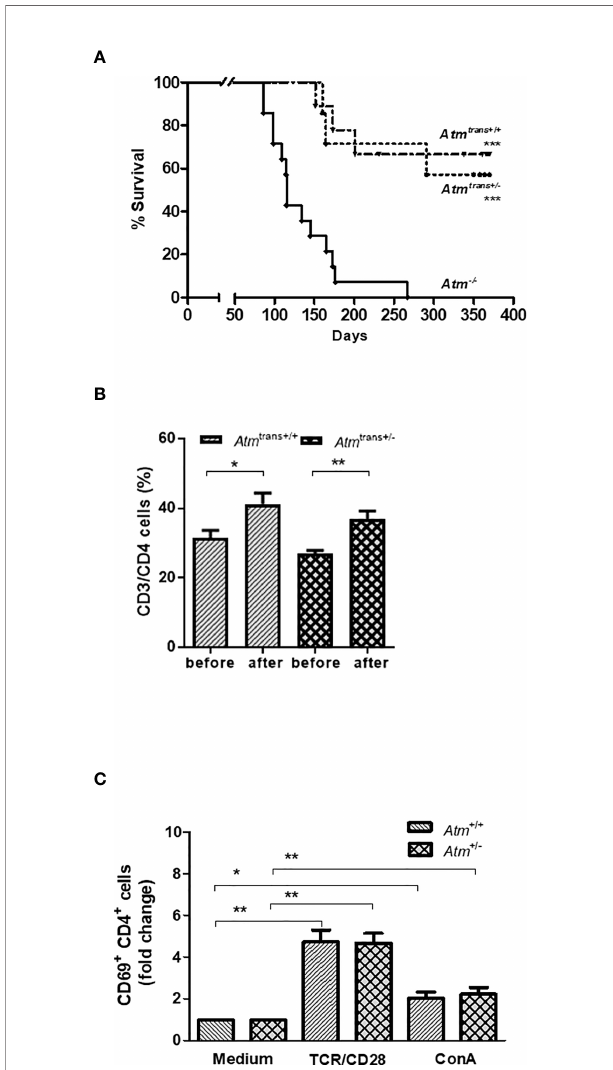
FIGURE 6 | Effects of HSCT with BMDCs isolated from heterozygous ( Atm +/- ) donors on survival and chimerism in Atm -de fi cient mice and functional T-cell activation of splenocytes from Atm +/- mice in vitro . (A) Survival curves shown as Kaplan-Meier plot from Atm -/- mice after heterozygous ( Atm +/- , n = 7) or homozygous ( Atm +/+ , n = 9) HSCT and Atm -/- without treatment (n = 14). (B) Phenotypic analysis of CD4 + T cells in peripheral blood taken from Atm - de fi cient mice before and 24 weeks after receiving BMDCs from Atm +/- or Atm +/+ donors (n ≥ 4) using fl ow cytometry. (C) Functional analysis of CD4 + , CD4 + / CD44 dim (naïve) and CD4 + /CD44 bright (memory) CD69 T-cell activation in splenocytes isolated from Atm +/- and Atm +/+ mice stimulated with either TCR/ CD28 or ConA for 4 h in vitro (n = 5). The data were normalized to the medium control. Data are presented as mean ± SEM. * p < 0.05, ** p < 0.01. ConA, Concanavalin A; GFP, green fl uorescent protein; HSCT, hematopoietic stem cell transplantation; TCR, T cell